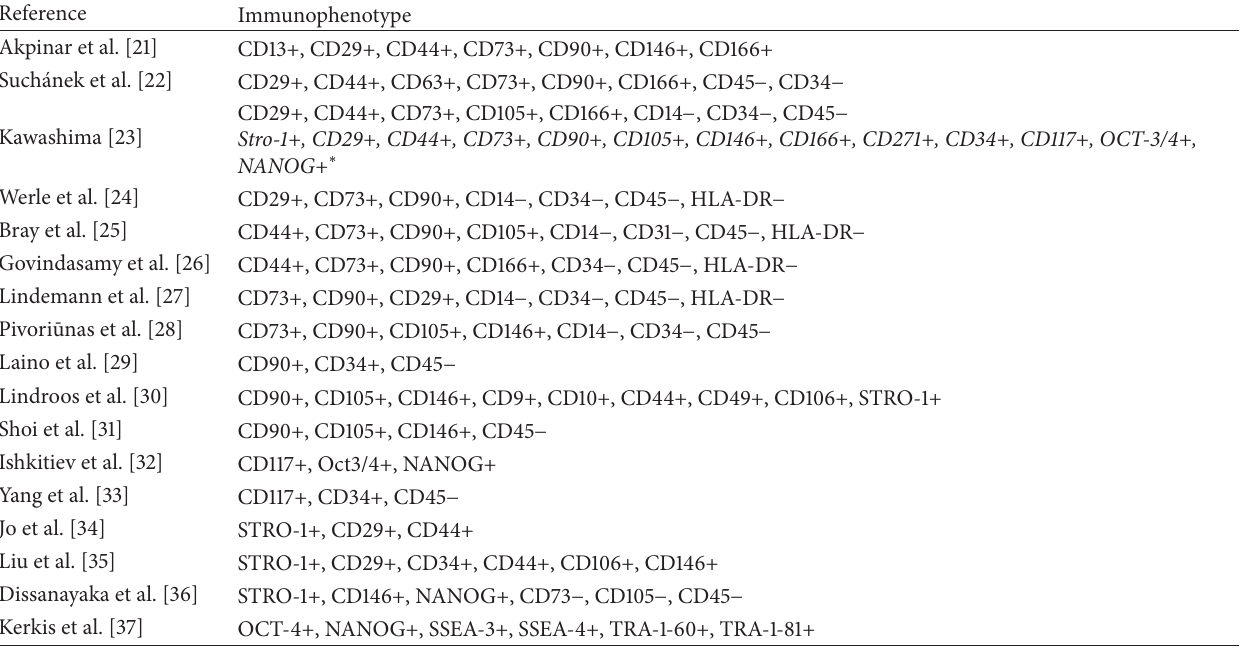
Table 1: Variants of human DPSCs